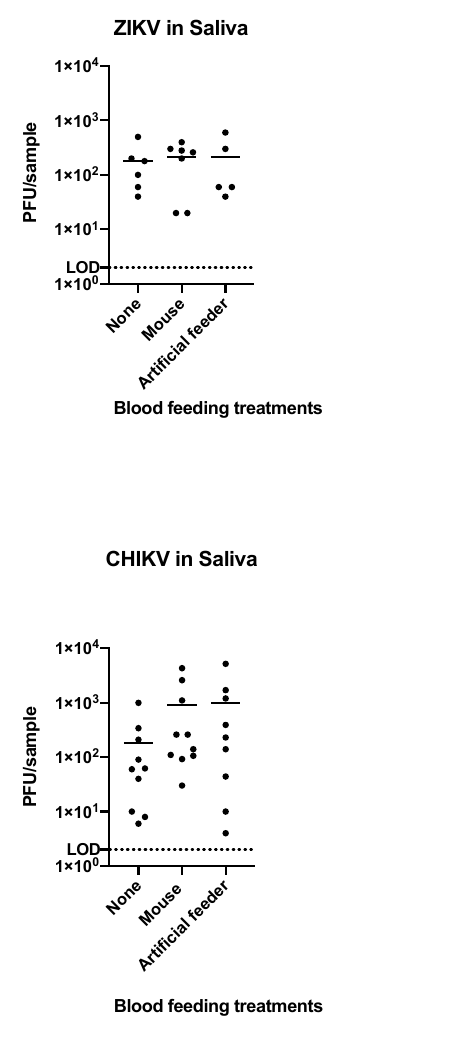
Figure 3. Quantification of ZIKV and CHIKV from groups of virus-positive saliva-samples collected from forced salivation Scheme 2 ( A , B ) or CHIKV ( C , D ; displayed in Table 3). LOD = limit of detection. Titer LOD = 2 PFU; genome copies LOD = 10. Means of virus titers or genome copies from saliva collected by either method (horizontal bars) were not significantly different (one-way ANOVA and post hoc Tukey test; p ≥ 0.05).